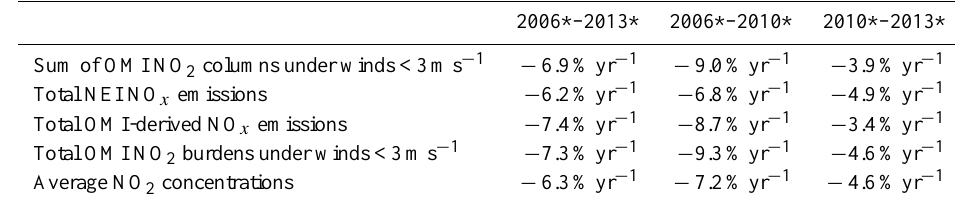
Table 2. Summary of NO x -related trends over all selected US urban areas during 2006*–2013* a .